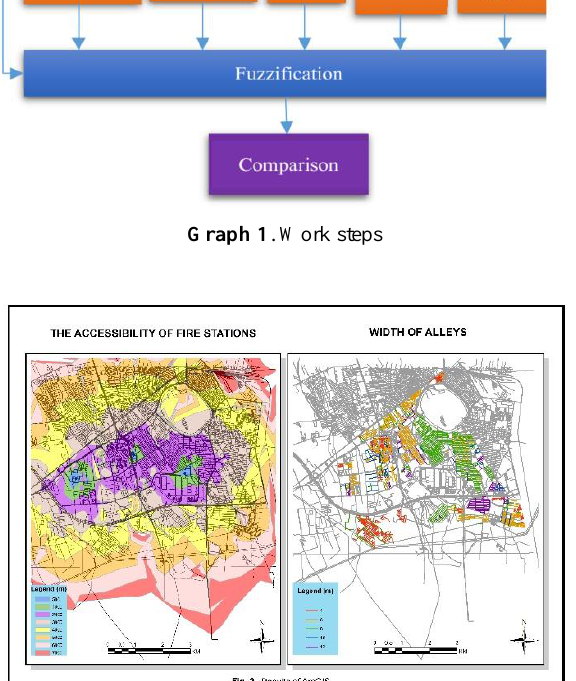
Figure 2 . Results of